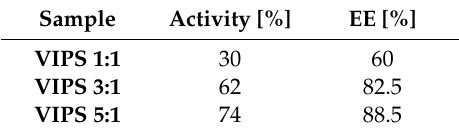
Figure 7. TGA curves of VIPS3:1 at different timing .